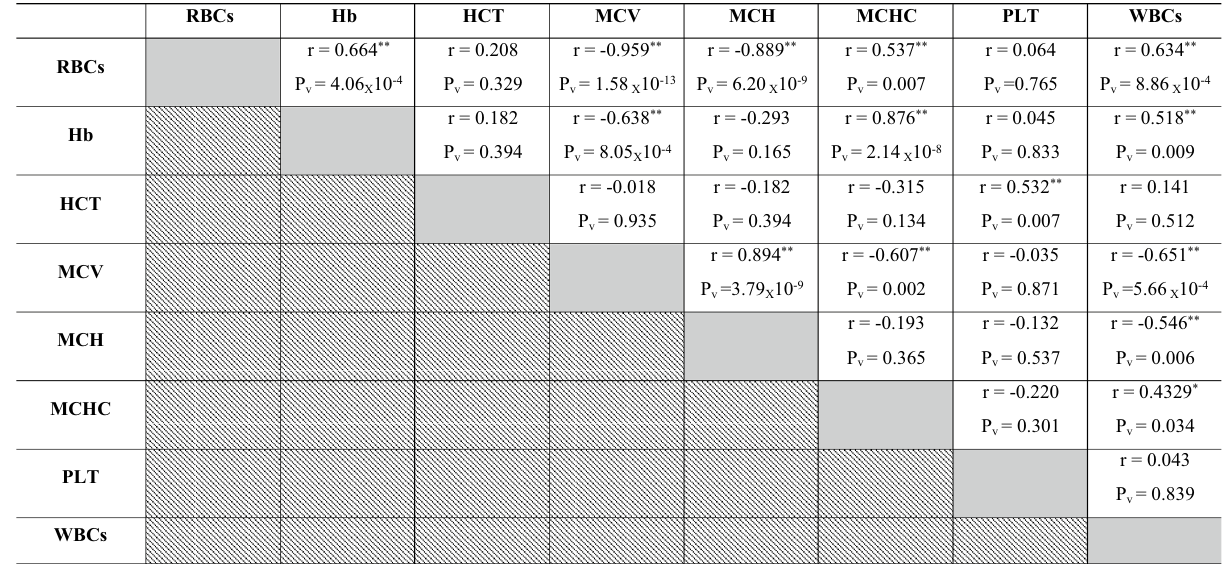
Table 2. Pearson correlation coefficient between blood picture indices in investigated Dabb lizards. RBC Red blood corpuscles, Hb Haemoglobin concentrations, HCT Haematocrit value, MCV Mean corpuscular volume, MCH Mean corpuscular haemoglobin, MCHC Mean corpuscular haemoglobin concentration, PLT Platelets, WBC White blood cell, R Correlation. P v : P value: *Significant (two-tailed) p < 0.05. **Significant (two-tailed) p < 0.01. Gray backgrounds referred to correlation between the same parameter e.g. RBCs and RBCs where there was no correlation. Diagonal backgrounds referred that this correlation was previously reported in the previous row e.g. correlation between RBCs and Hb was reported in row 1 and so there was no need to repeat it at row 2.